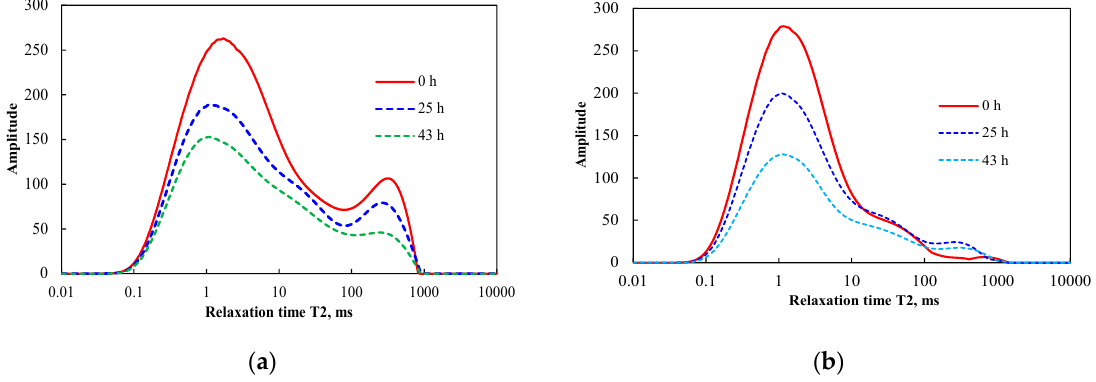
Figure 16. The T 2 spectra vs soaking time in WEH-1 and WEH-2 samples: ( a ) WEH-1 and ( b ) WEH-2.